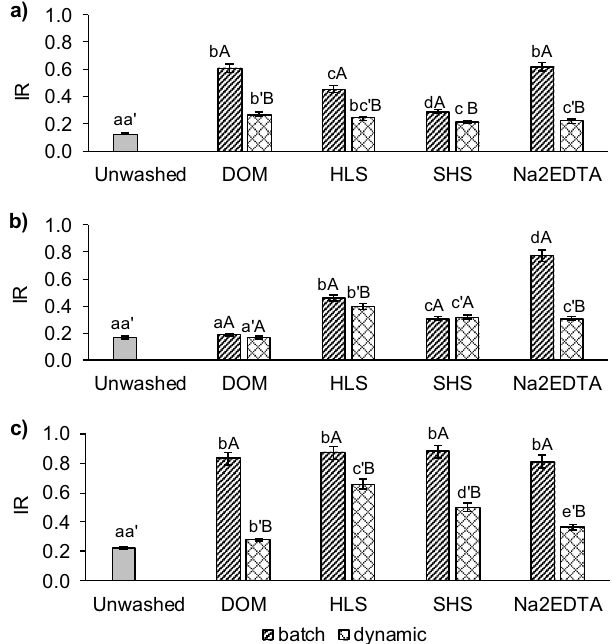
Figure 5. Assessment of the strength of metals bonding (as IR ) in unwashed soil and soil treated with different washing agents: ( a ) Cu, ( b ) Pb, and ( c ) Zn. Significant differences (mean ± SD, p < 0.05, Statistica 13.1) for IR between soils washed under batch conditions (abc), between soils washed under dynamic conditions (a’b’c’) and between washing conditions with the use of the same washing solution (AB) are marked with specific